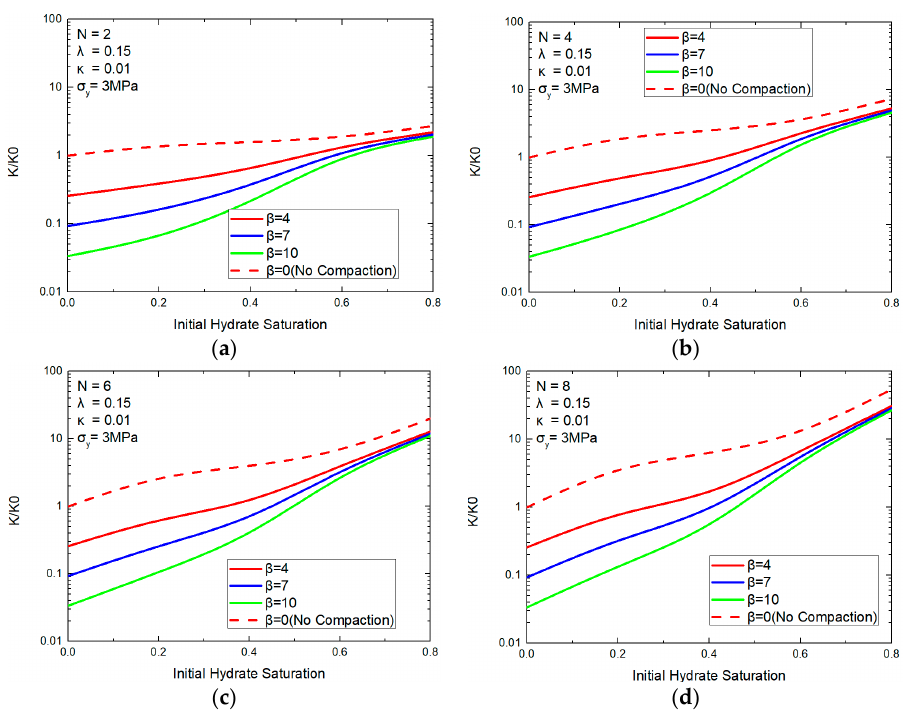
Figure 13. The effect of parameter β on the relationship between permeability ratio K/K 0 and initial hydrate saturation when ( a ) N = 2, ( b ) N = 4 , ( c ) N = 6 (d) N = 8 in the case of heat insulation. The effects of the soil deformation parameters ( λ , κ and σ ’ yi ) on the permeability ratio K/K 0 are shown in Figure 14. As the sediment becomes softer (large values of λ , κ and a smaller value of σ ’ yi ), the soil compaction effect on permeability is greater and the K/K 0 values reduce. Again, the soil compaction effect becomes more apparent in the insulated scenario compared with the constant temperature scenario, indicating the importance of heat transfer to dissociate hydrate fully.